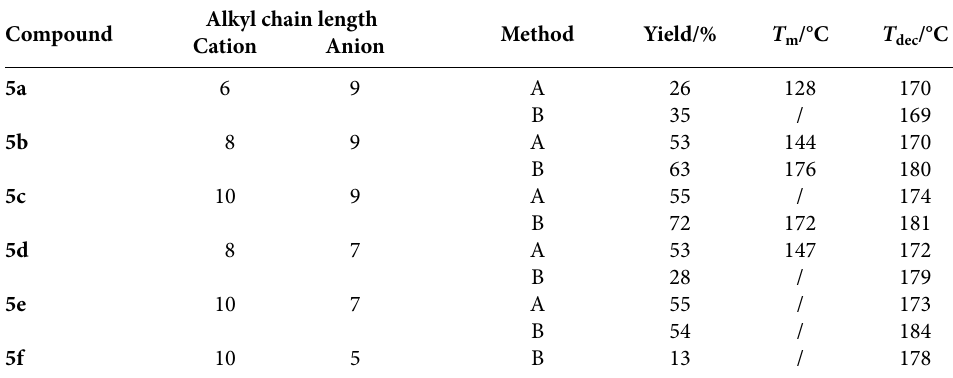
Table 1. Yields and thermal data for the prepared compounds by the two methods.